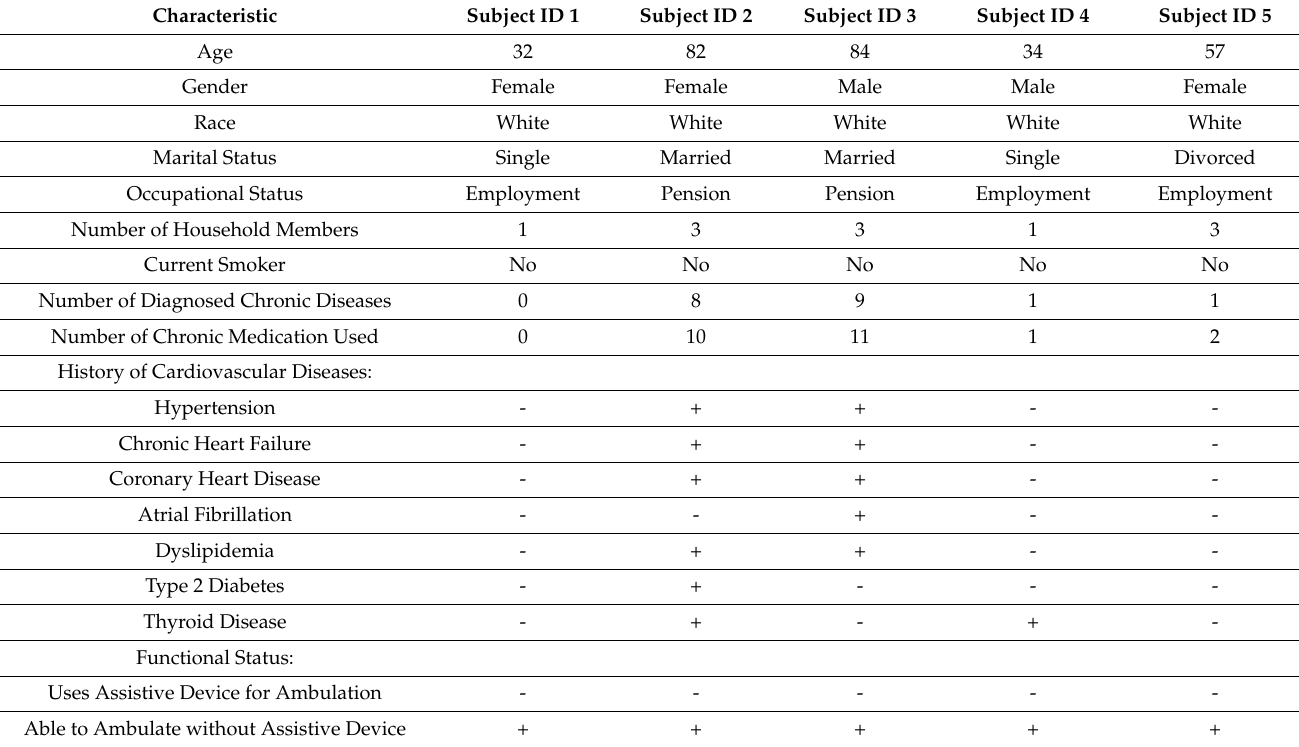
Table legend: + (yes), -